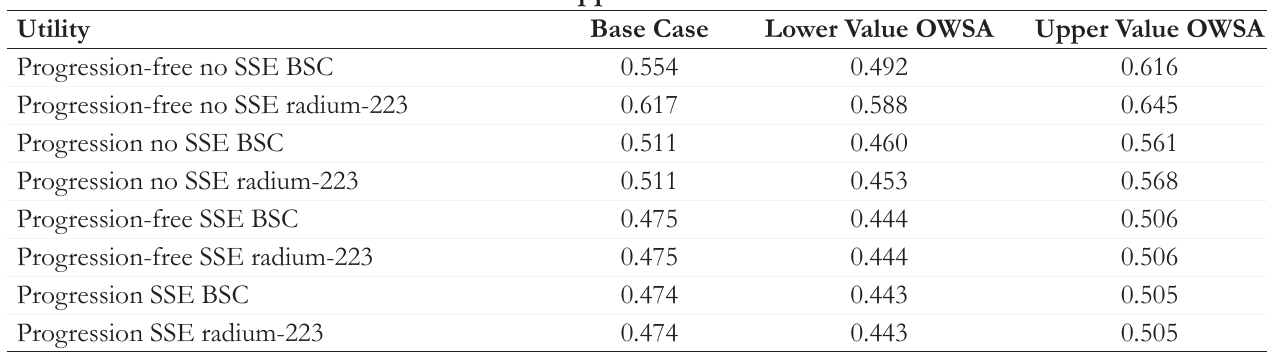
Table 2. Utilities to Radium-223 and Best Supportive Care